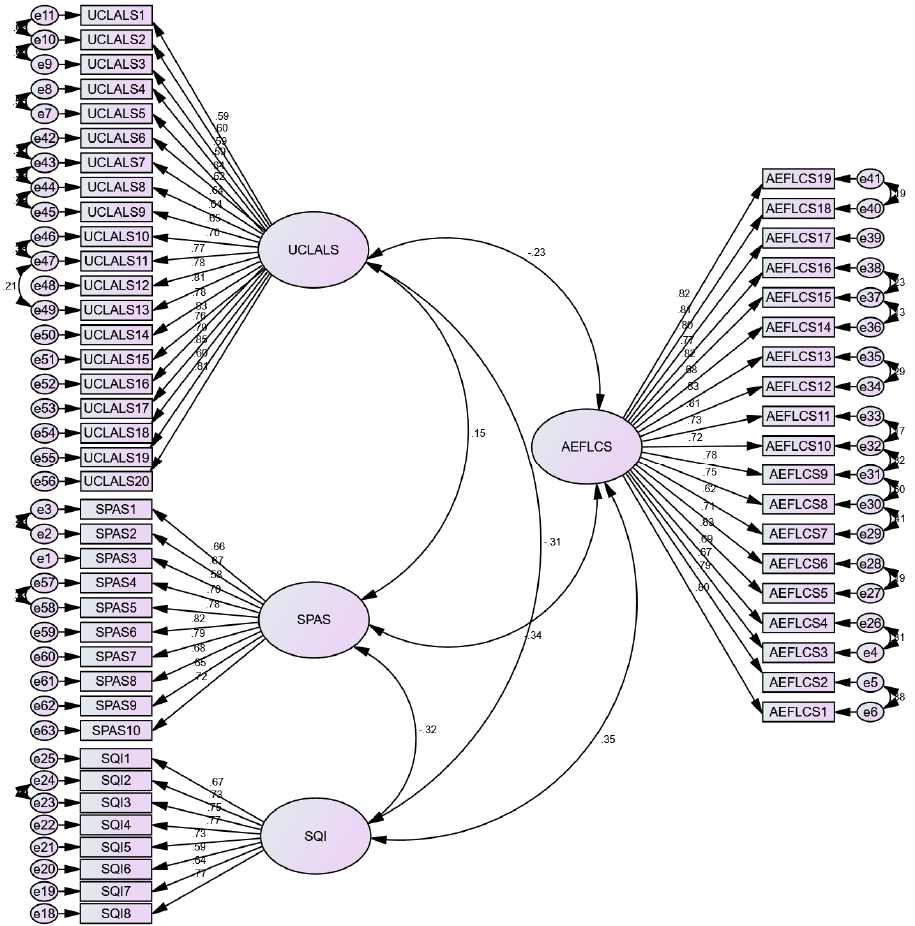
Figure 2 . Measurement model diagram. Note: UCLALS = the revised University of California Los Angeles Loneliness Scale; SPAS = the Smartphone Addiction Scale; SQI = Sleep Quality Index; AEFLCS = the Attention in EFL Class Scale.